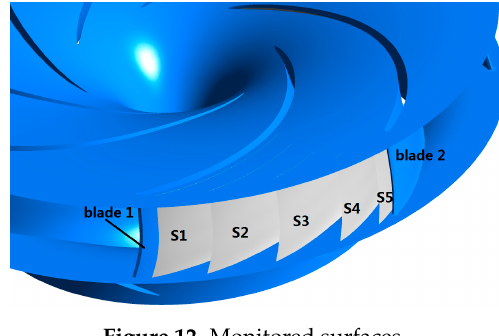
Figure 12. Monitored surfaces.